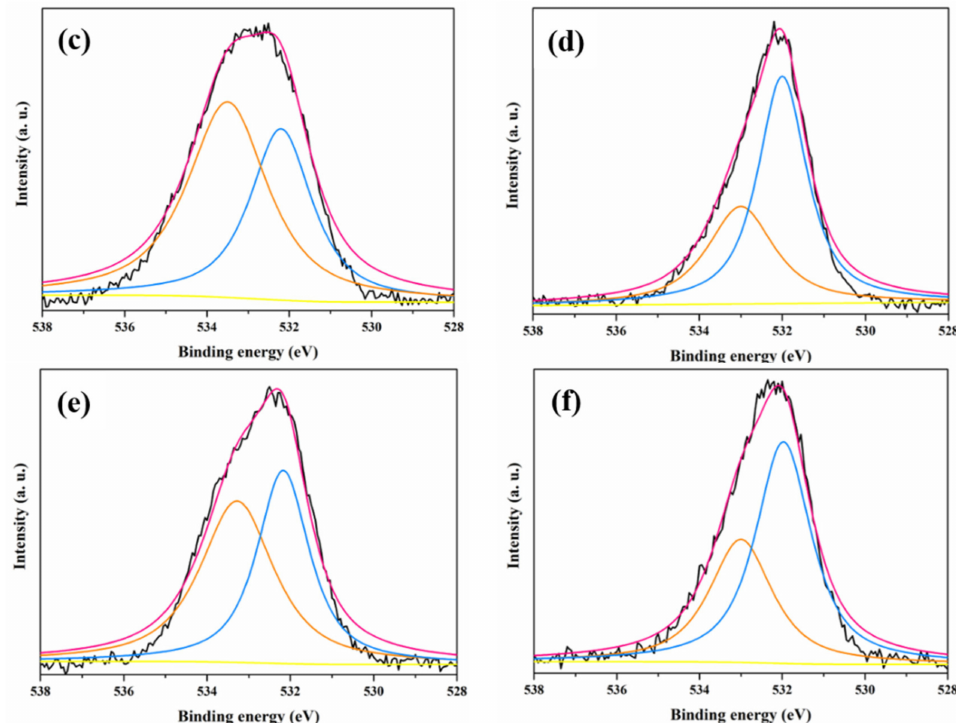
Figure 2. Deconvoluted O1s spectra of six PSt-based microspheres; ( a ) PSt, ( b ) P(St-AA), ( c ) P(St-MMA-AA), ( d ) P(St-MMA), ( e ) P(St- BA-AA), and ( f )